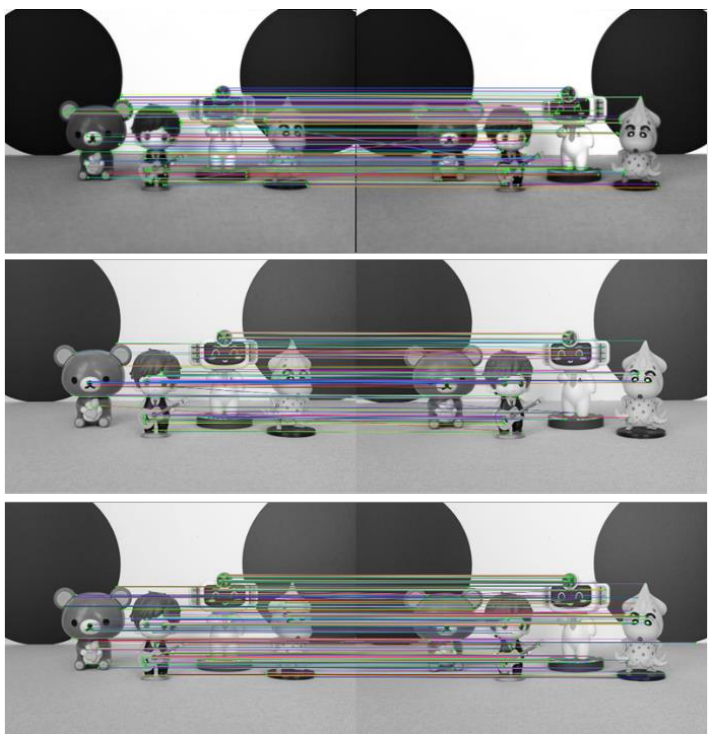
Sensors 2023 , 23 , x FOR PEER REVIEW Figure 9. Scene 3 image feature point matching results. Figure 9. Scene 3 image feature point matching results.